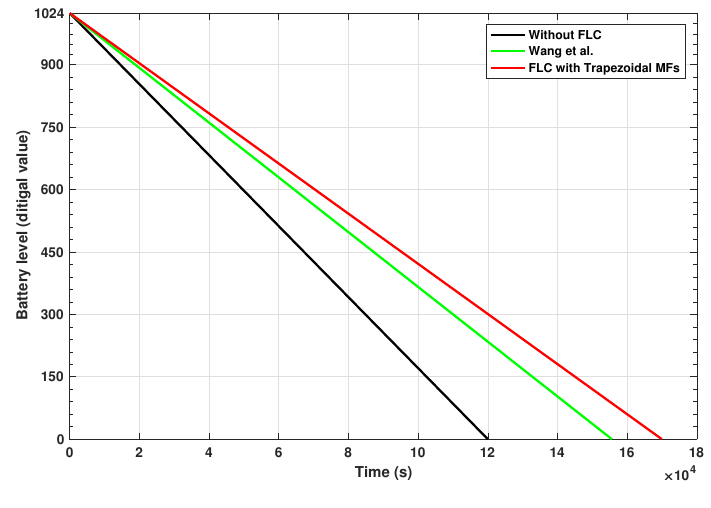
Figure 7. Battery